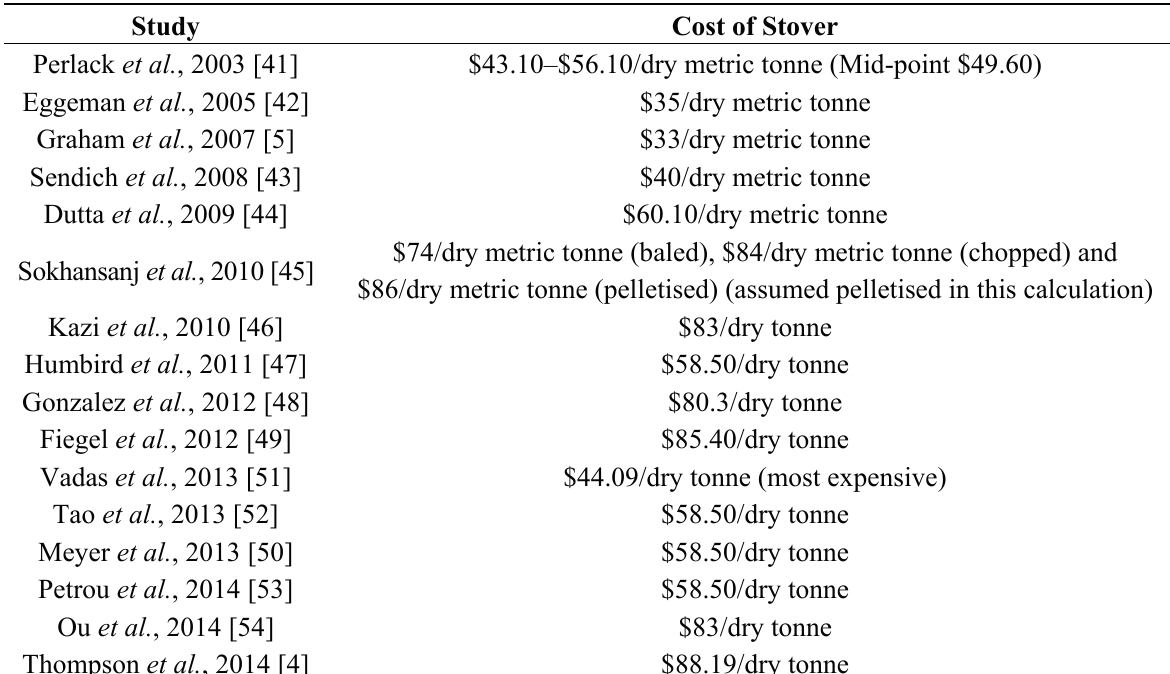
Table 2. Estimates of maize stover C RM found in literature